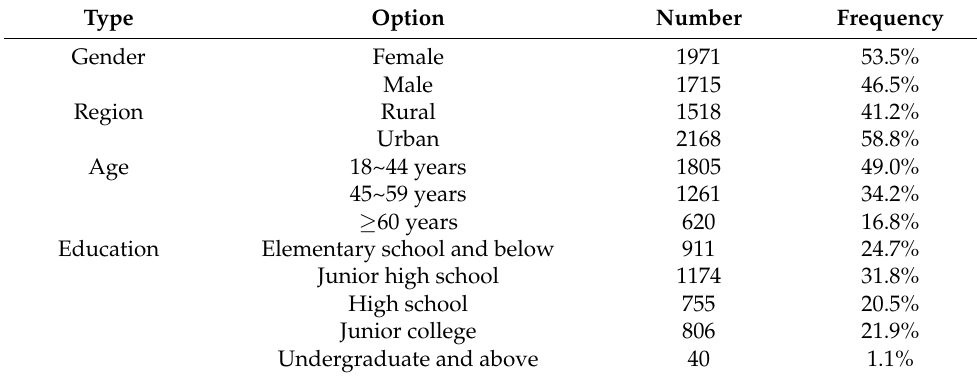
Table 1. Demographic characteristics of the